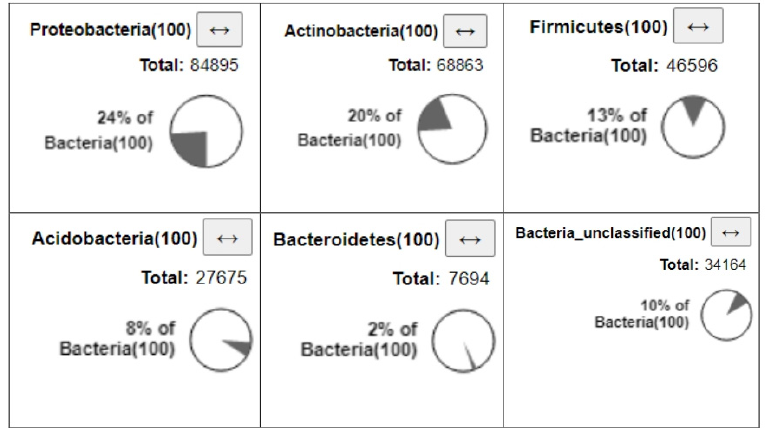
Figure 3. Total number of reads and percent of bacteria diversity of stalactites homogenized cores samples at phyla level.